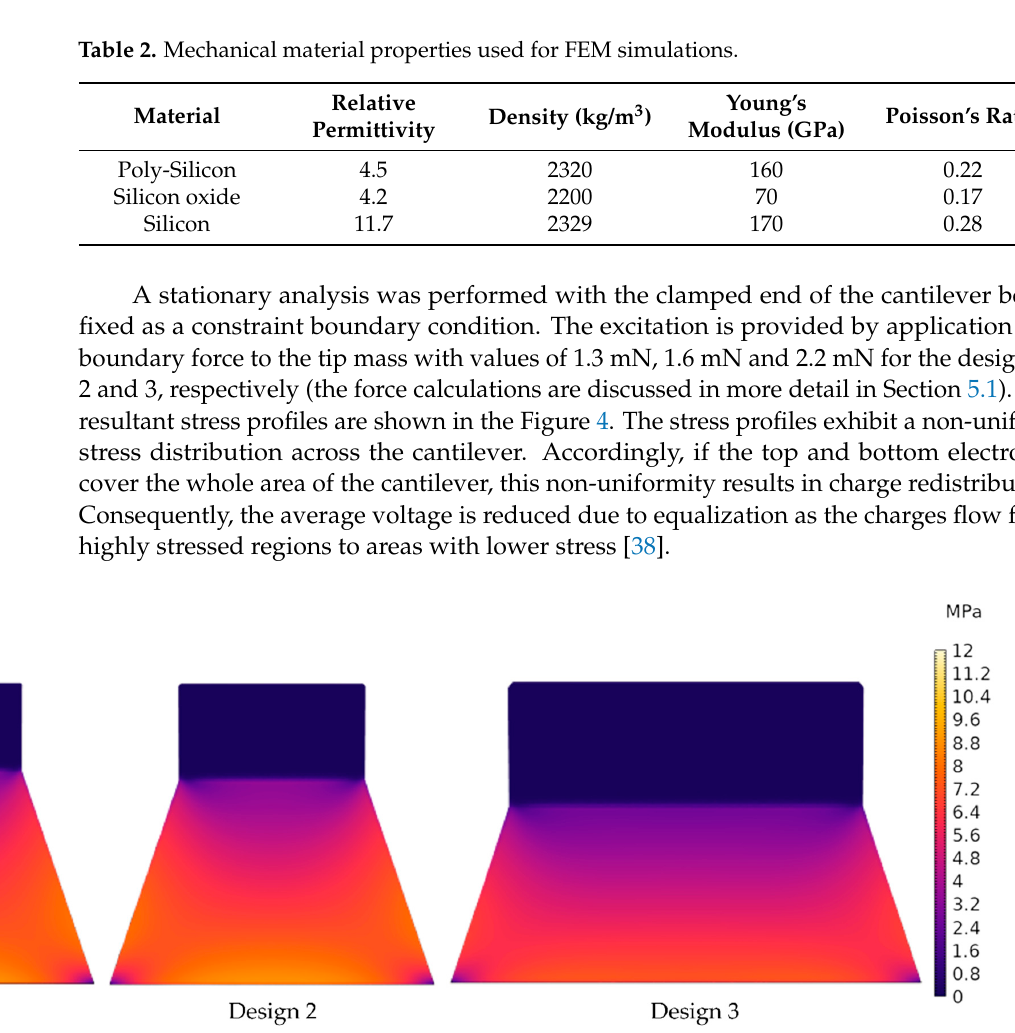
Figure 4. FEM simulated von Mises stress contour plots for the three harvester designs.